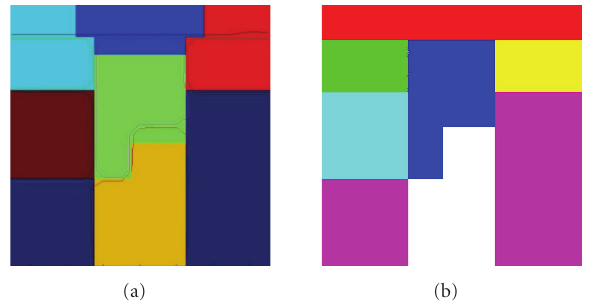
Figure 7: Segmentation results on a synthetic field, without any noise added. (a) Results of [4] displayed on the results obtained with the K-means algorithm. (b) Results from our algorithm.